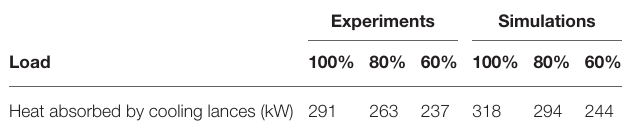
TABLE 4 | Experimental and simulation results on heat absorbed by the lances.